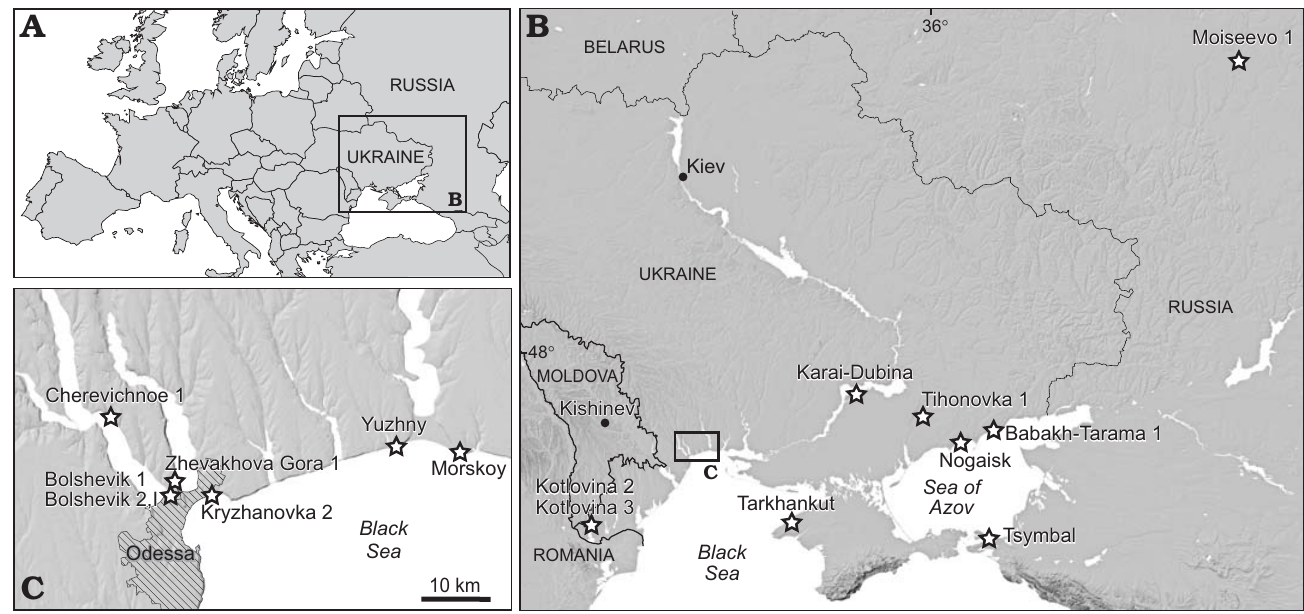
Fig. 1. Geographic location of Spermophilus -bearing fossil localities (stars) discussed in the text.